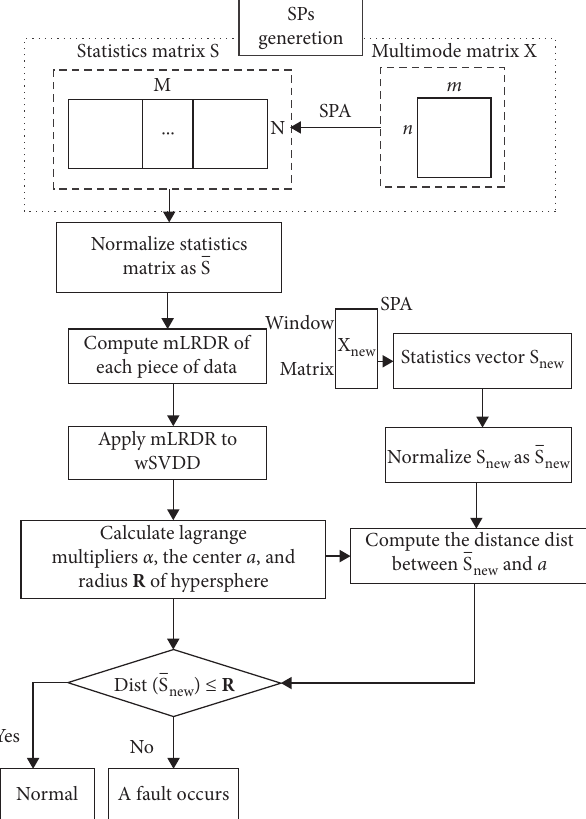
Figure 1: Flowchart of SmLRDR-wSVDD scheme for multimode